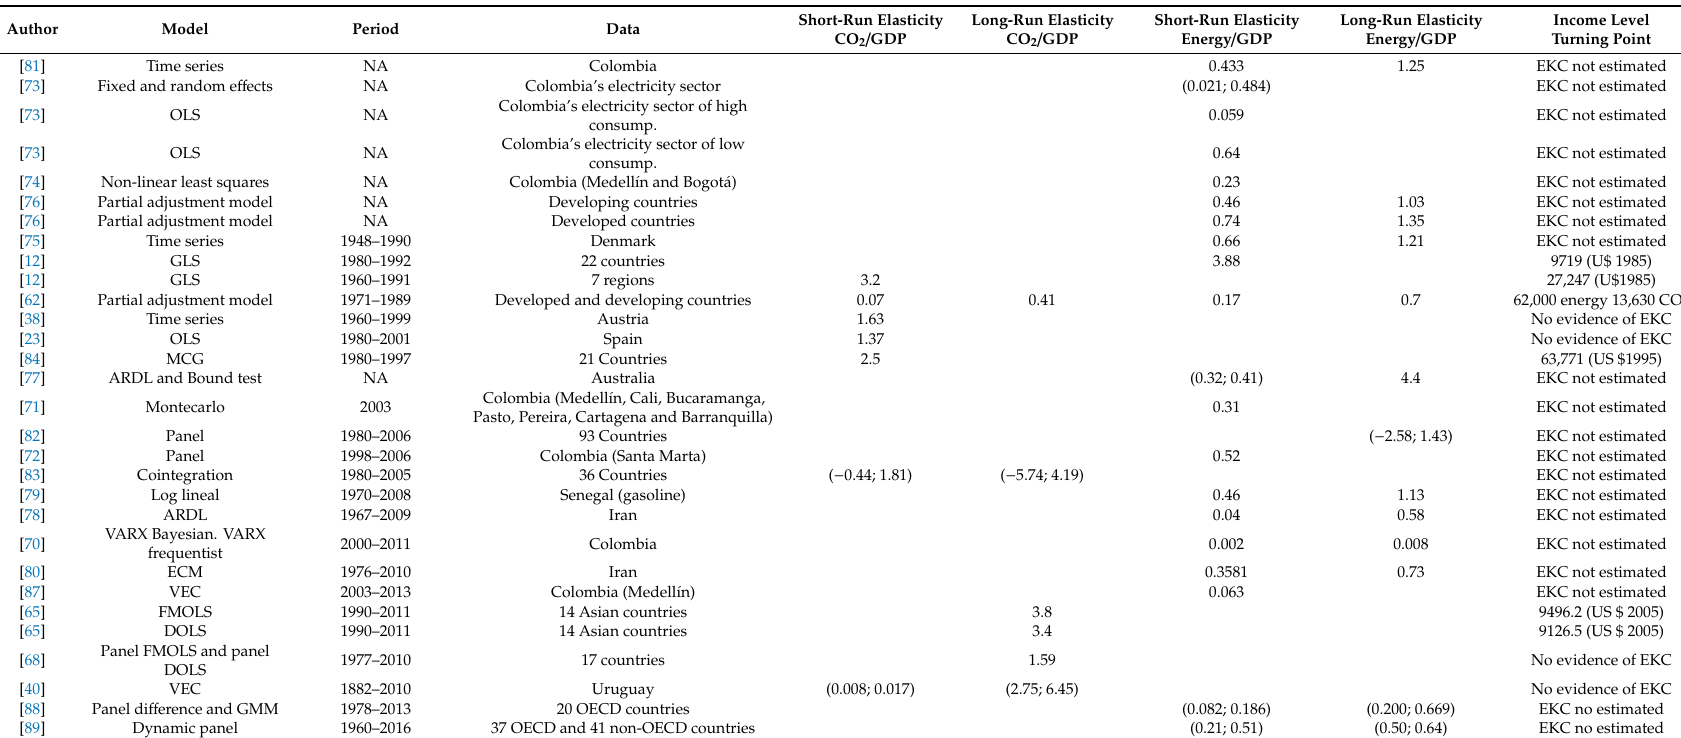
Table A1. Review of Selected Articles Related to Income Elasticity of Energy and CO 2